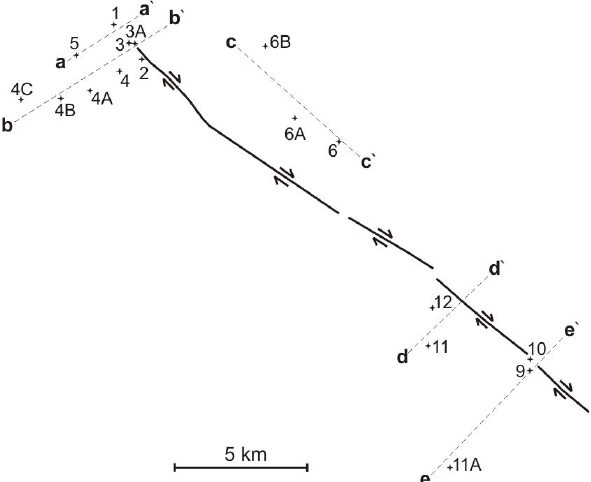
Fig. 2. Measurement